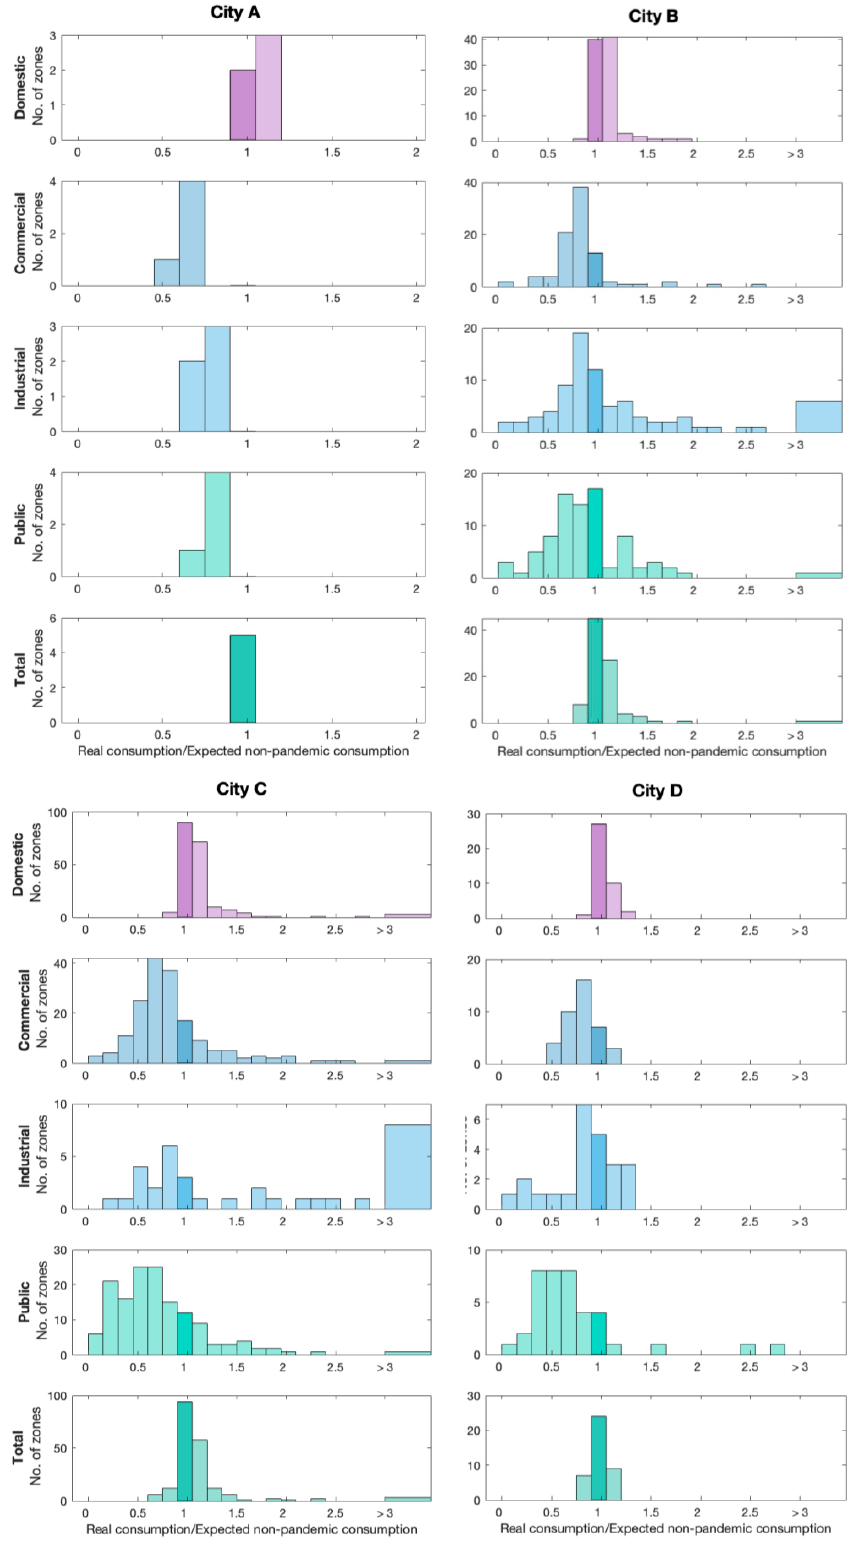
Figure 6. Comparison histograms of the water consumption changes due to the COVID-19 pandemic by geographic divisions within each case study. The 0.9–1.05 range, presented in a darker tone, represents zones where the consumption was nearly the same between normal and pandemic-affected data.